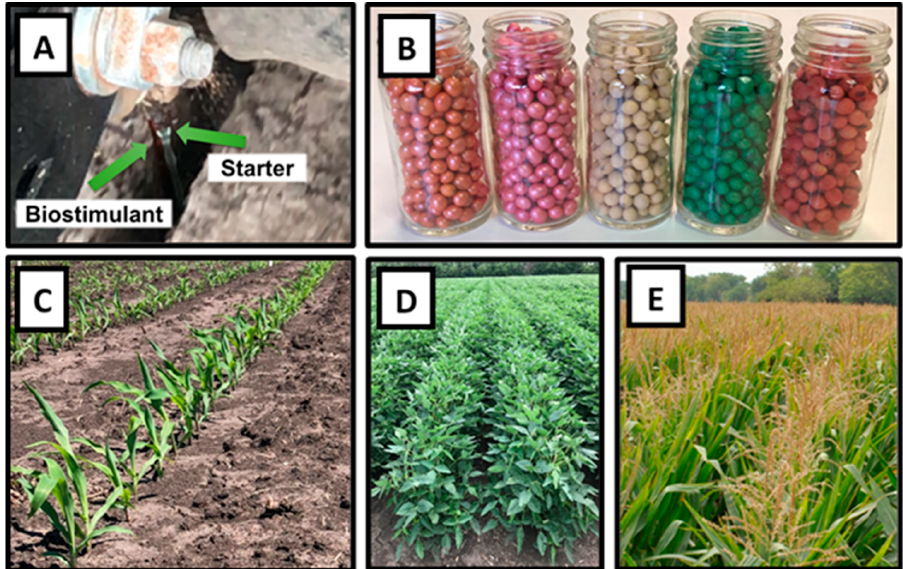
Figure 1. Crop growth stages representing the potential “free-ride” opportunities for applications of biostimulants with other management practices in row crop systems. ( A ) At planting as a liquid in-furrow. ( B ) On the seed as a seed treatment. ( C ) Early postemergence herbicide timing (~V5 growth stage maize and soybean). ( D ) Fungicide timing in soybean (~R3 growth stage). ( E ) Fungicide timing in maize (VT/R1 growth stage).